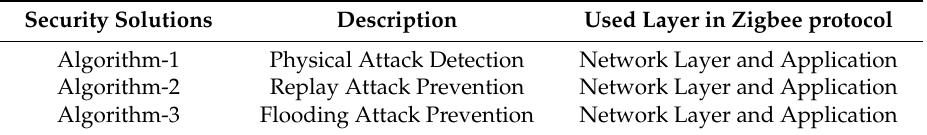
Table 6. Security solutions in the proposed Security Improvement Framework (SIF).